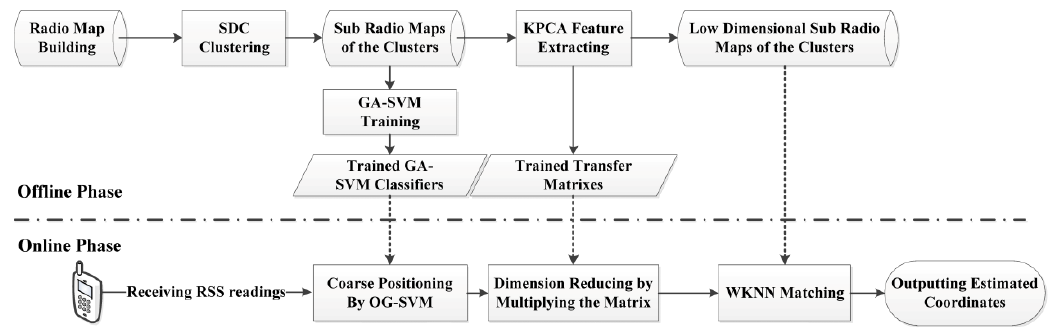
Figure 2. Flow chart of the proposed indoor positioning